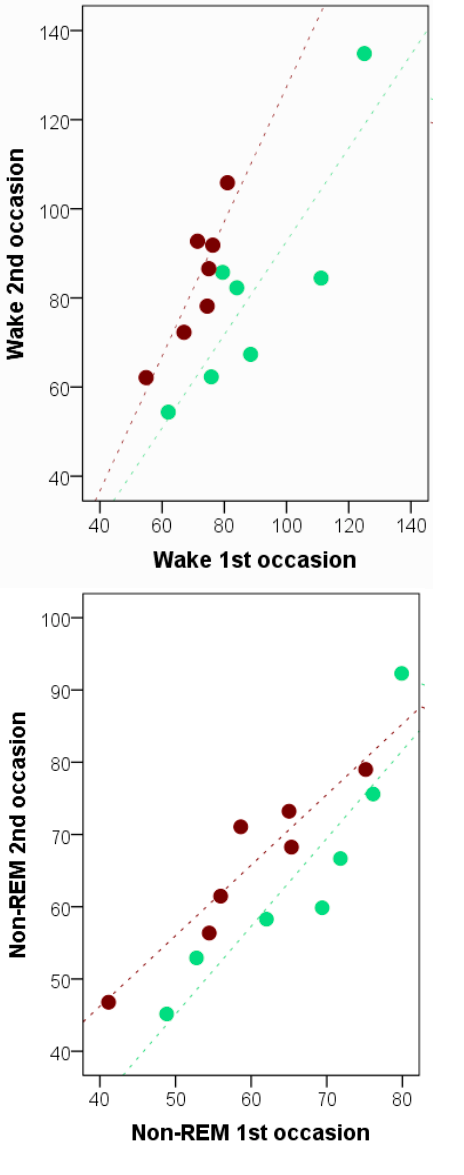
Figure 4. Relationship between heart rate during the first versus the second occasion in dogs staring with PSI and dogs starting with NSI (5 min sampling from the first occurrence of wakefulness, drowsiness, non-REM and REM).